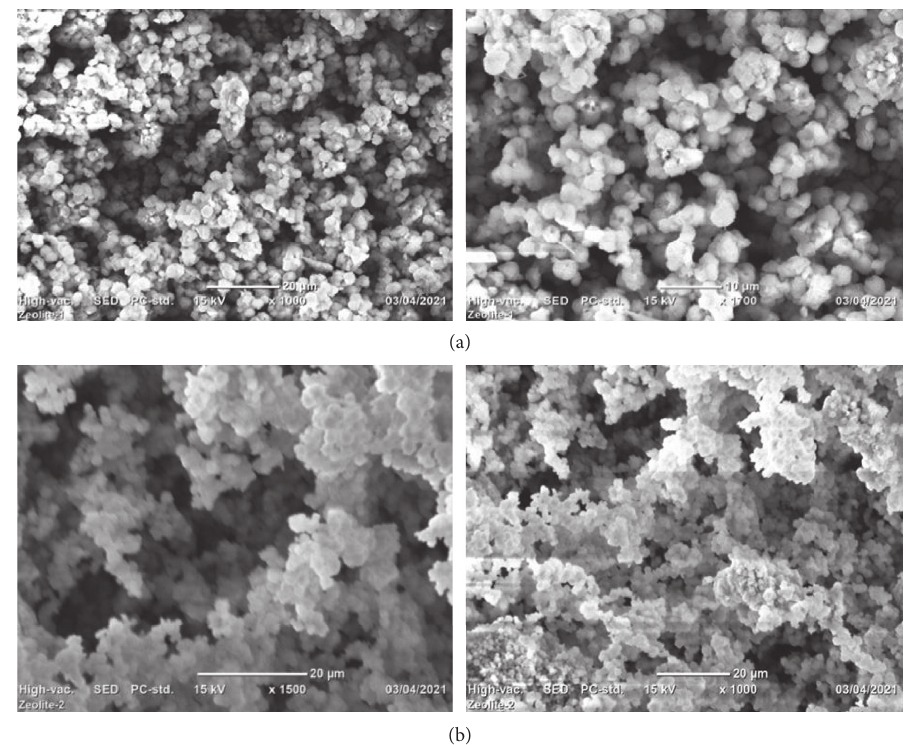
Figure 2: SEM image of (a) Z-A and (b) Z-B at different magnification.